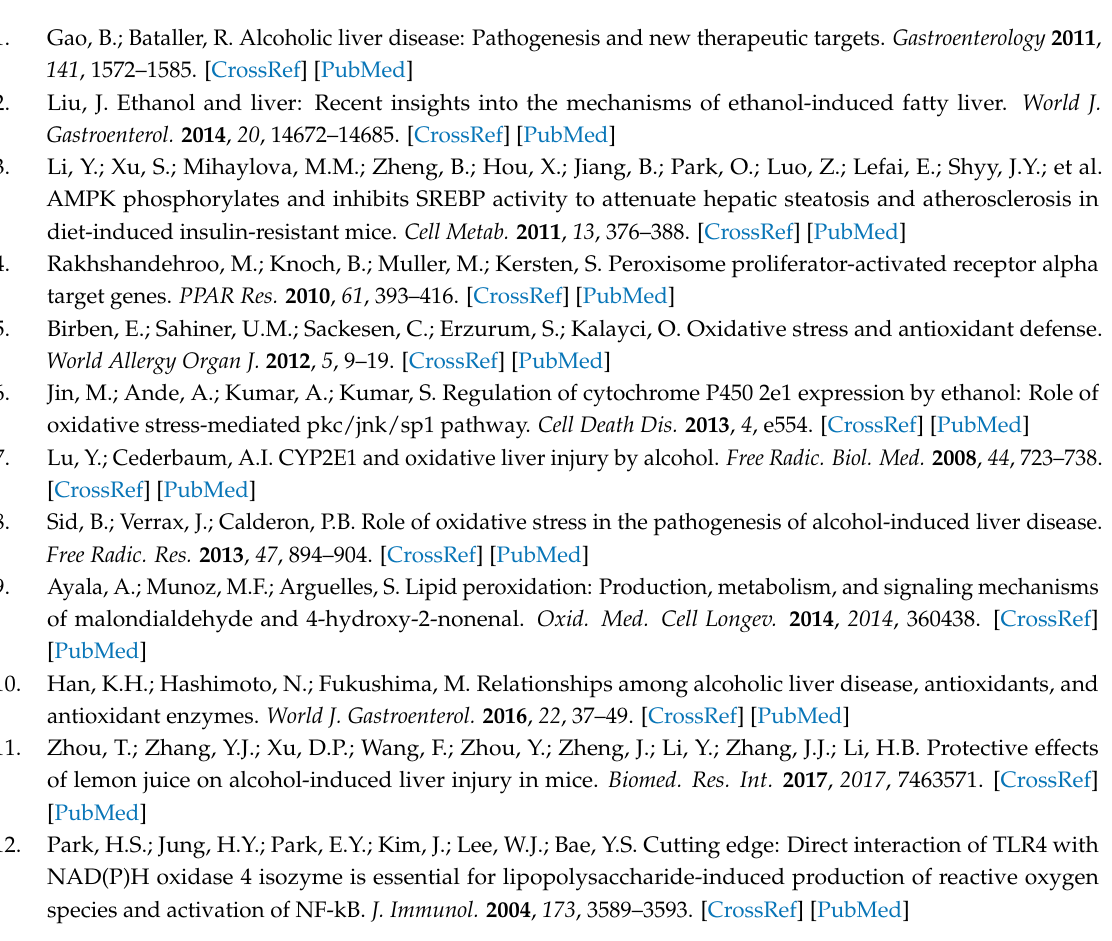
Table S1: Composition of the aqueous extract of pepino leaf (AEPL). Table S2: Composition of the aqueous extract of pepino leaf (AEPL) vs. pepino fruits. Table S3: Comparison of various plant-derived polyphenols. Author Contributions: H.-H.L. and J.-H.C. conceived and designed the experiments; J.-Y.H., C.-C.H. and B.-C.C. performed the experiments and analyzed the data; J.-Y.H., H.-H.L. and J.-H.C. wrote and edited the manuscript. Funding: This research received no external funding. Conflicts of Interest: The authors declare no conflict of